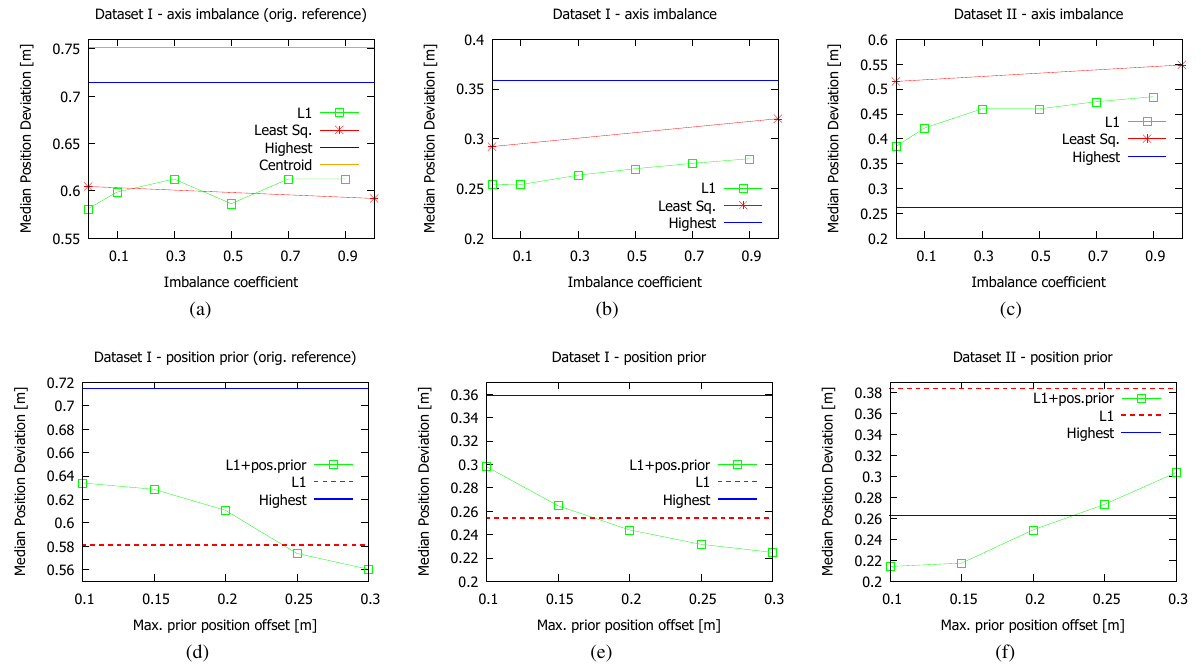
Figure 4. Median of tree position deviation as a function of maximum allowed axis imbalance (a)-(c) and maximum distance from apriori position (d)-(f). (a),(d) show result of comparison with original, unaltered measurements from field inventory, whereas (b),(c),(e),(f) are based on manually derived tree positions.